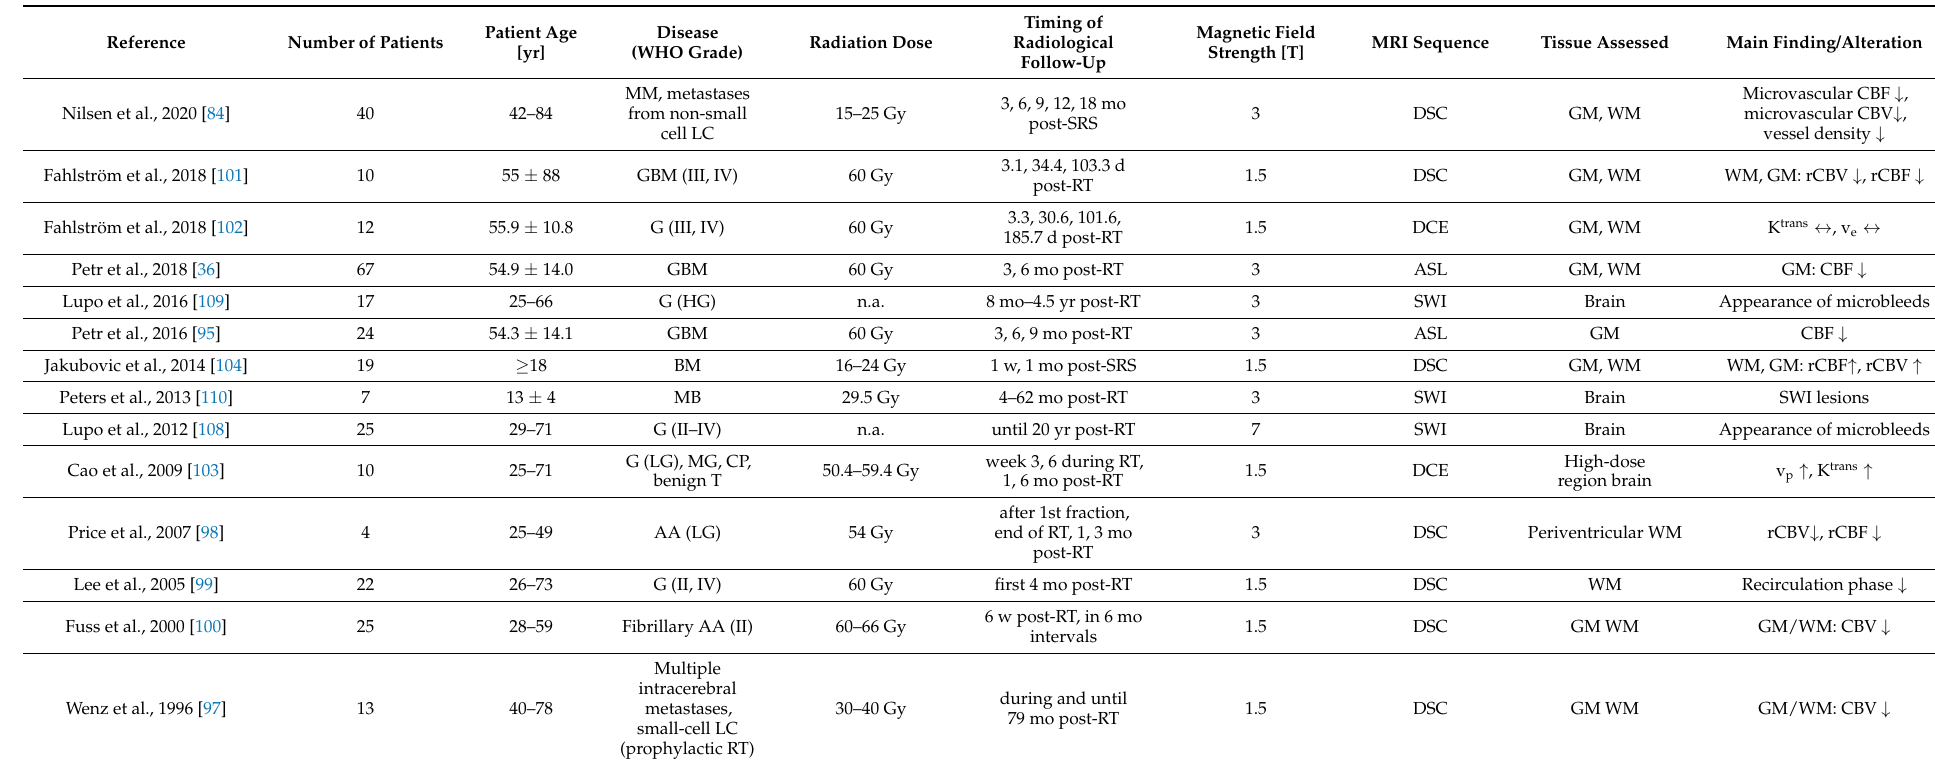
Table 3. Publications on vascular changes in normal-appearing tissue after